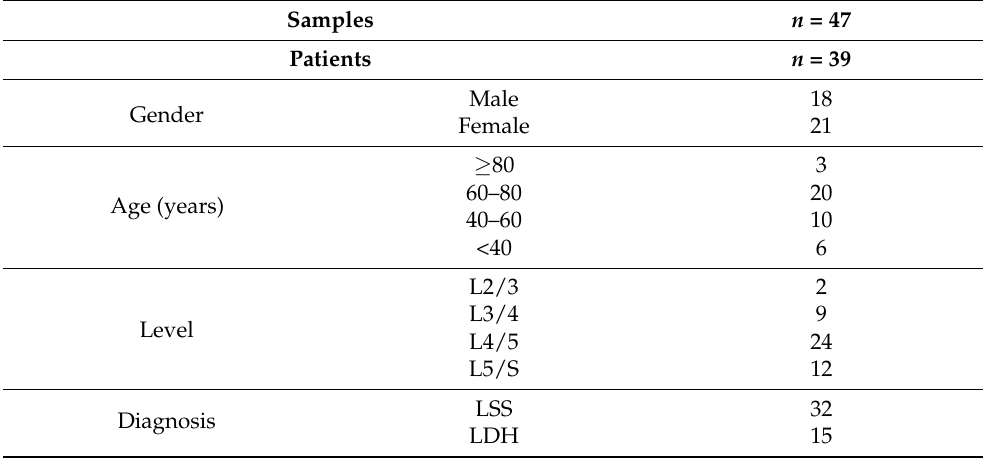
Table 1. Baseline characteristics of human surgical